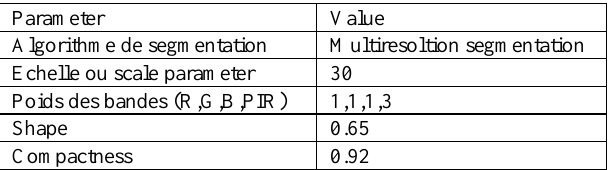
Table 2. Sentinel 2 image segmentation settings